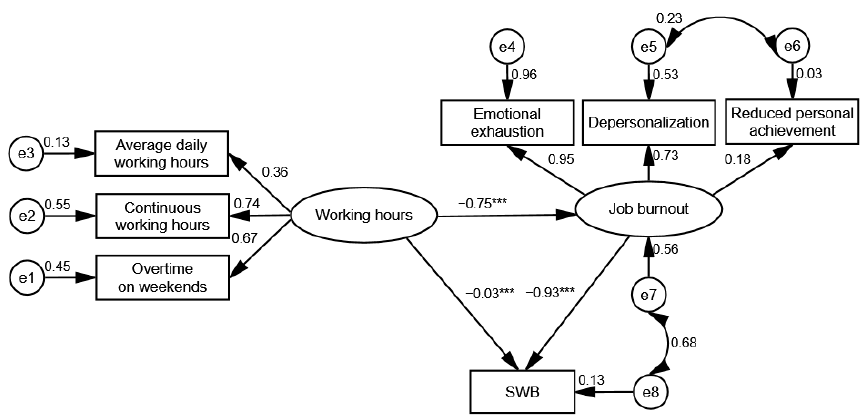
Figure 1. Mediating role of job burnout in working hours and SWB (M2). Note: *** P < 0.001.